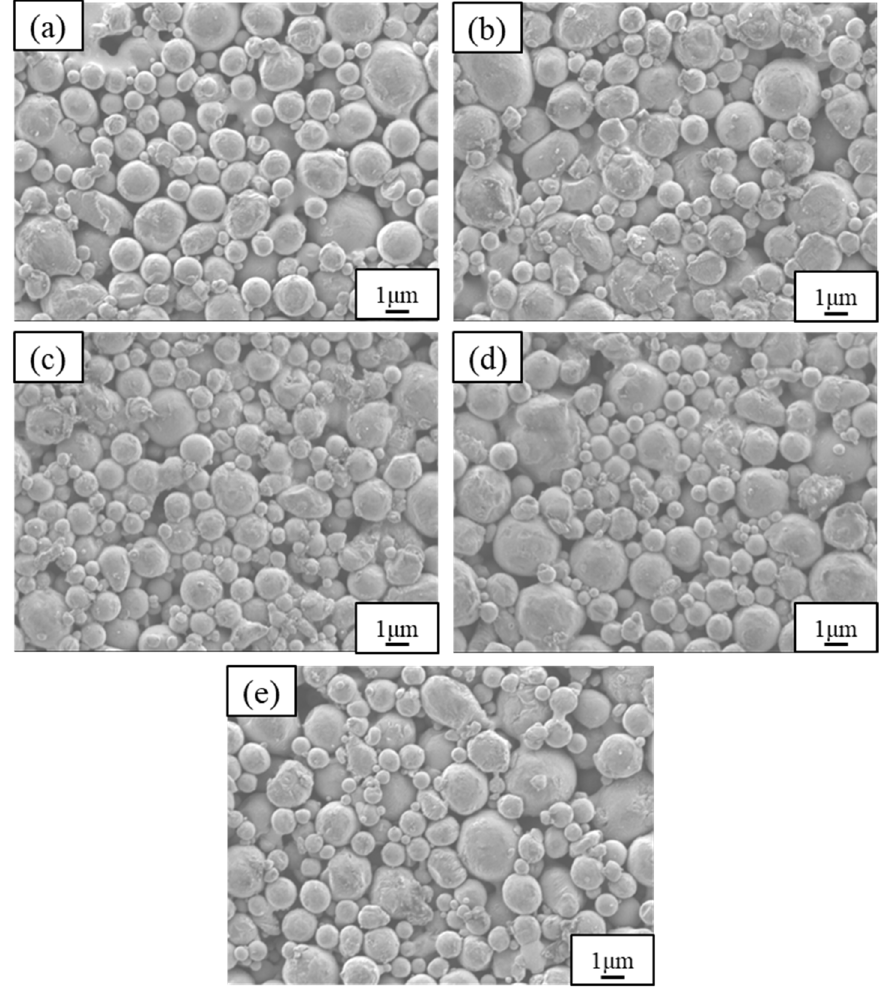
Figure 9. Surface SEM of aluminum film samples with different added sodium carbonate content.